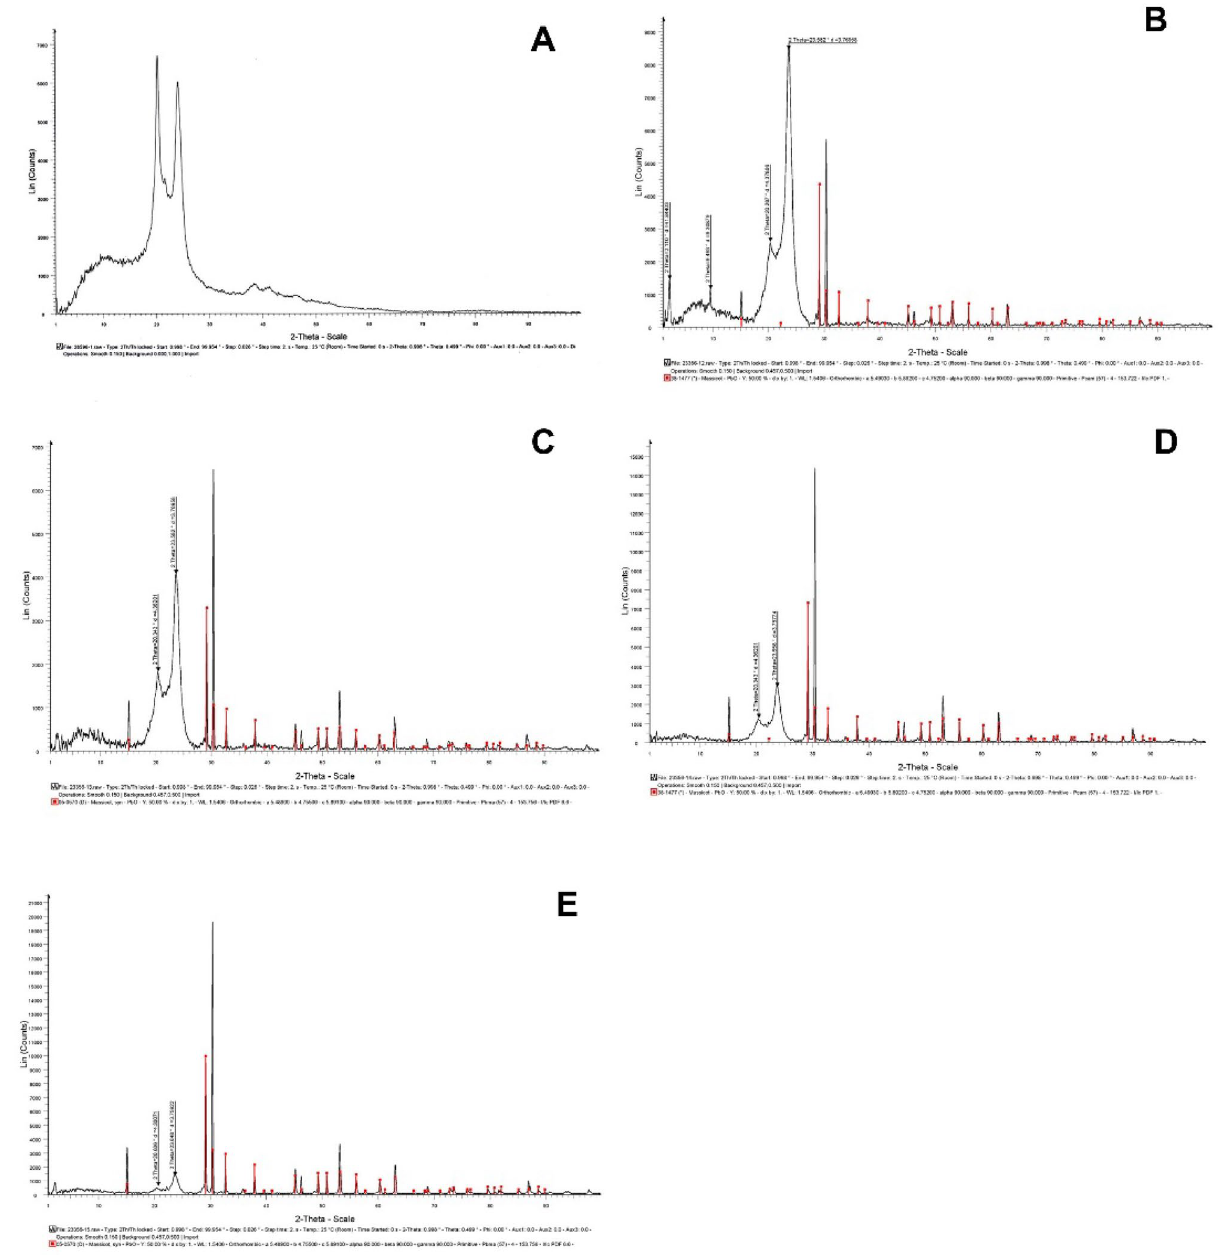
Figure 5. The XRD graphs of the PA6/PbO composites at various concentrations of the fillers, ( A ) 0 wt% (pure PA6), ( B ) 5 wt%, ( C ) 10 wt%, ( D ) 20 wt%, and ( E ) 50